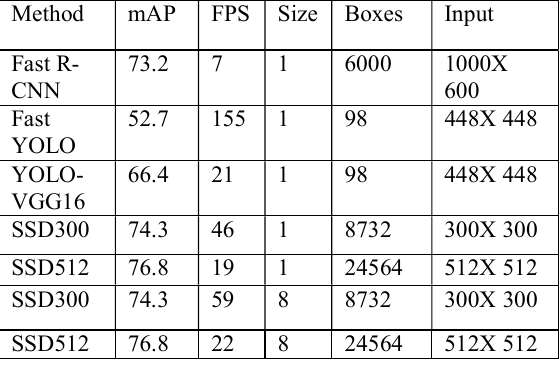
Table 2. Speed and Accuracy comparison among object detection algorithms.